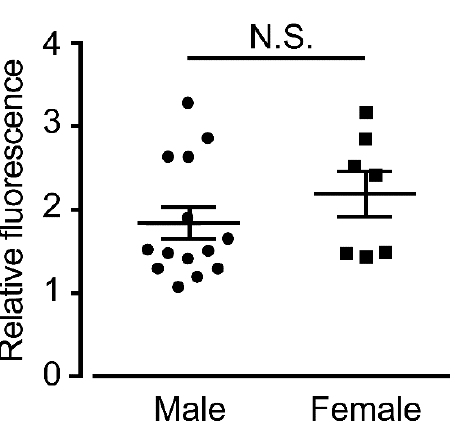
Figure A1. Fluorescence intensity in males ( n = 14) and females ( n = 7). Fluorescence intensity is expressed as a ratio of the amount of fluorescence in the 5-ALA supplemented group relative to the amount of fluorescence in the vehicle group for each sample. The horizonal lines indicate the mean ± SD.